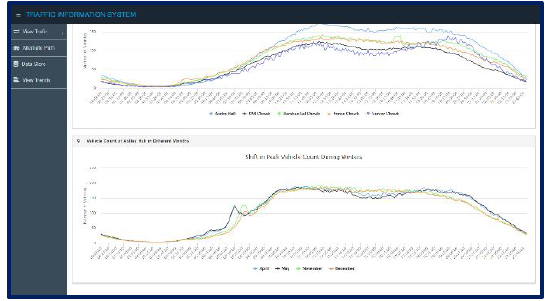
Figure 15: Visualization of Traffic Trends in the form of graphs